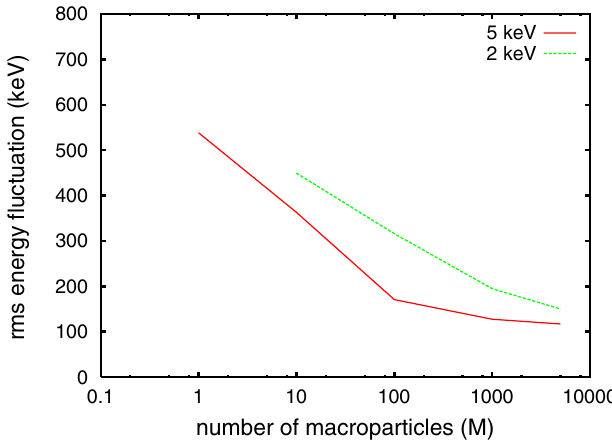
FIG. 6. (Color) The rms energy fluctuation at the exit of the linac as a function of the number of macroparticles used in the simulations. Two examples of beams with 5 and 2 keV initial uncorrelated energy spread are compared.